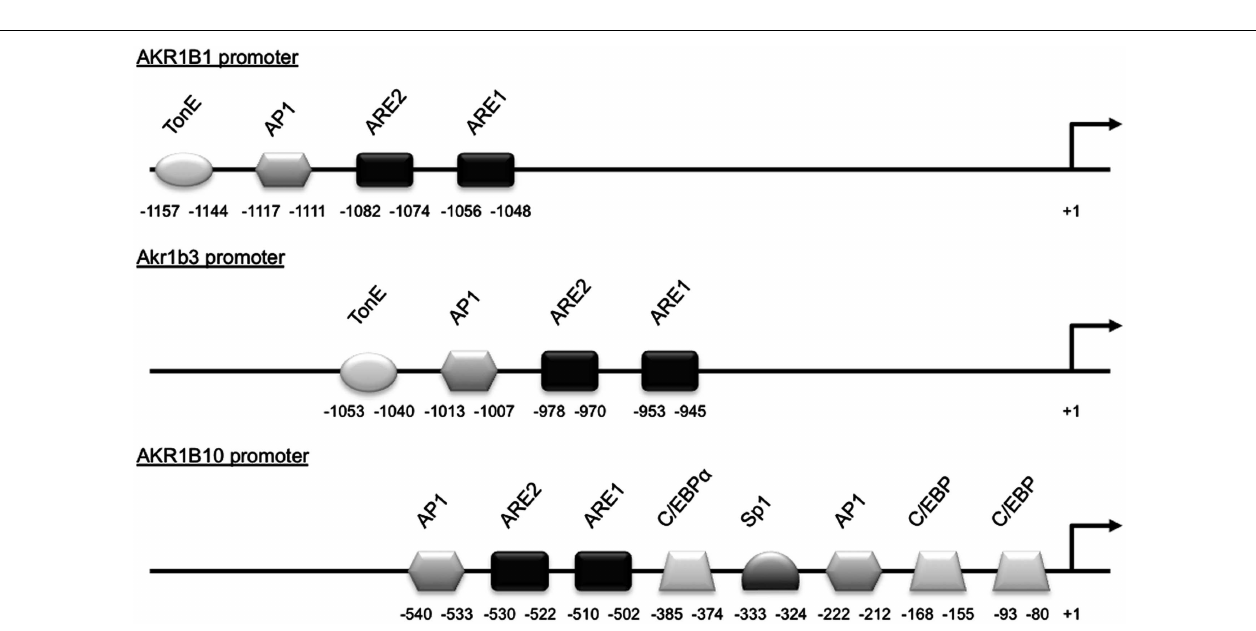
activator protein-1 binding site; ARE, antioxidant response element; C/EBP, CCAAT enhancer binding protein binding site; Sp1, selective promoter factor 1 binding